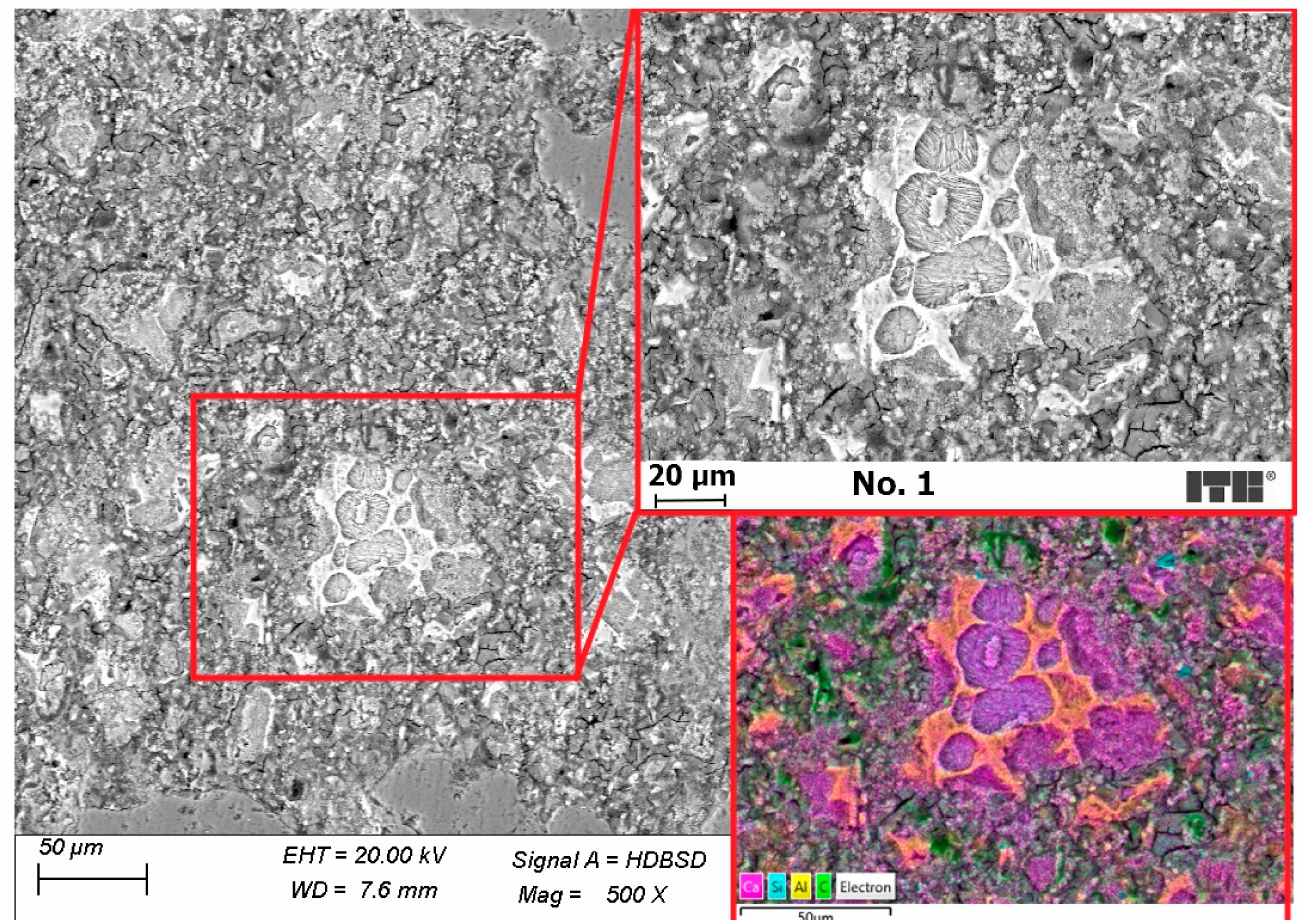
Figure 10. Mortar cured with product No.